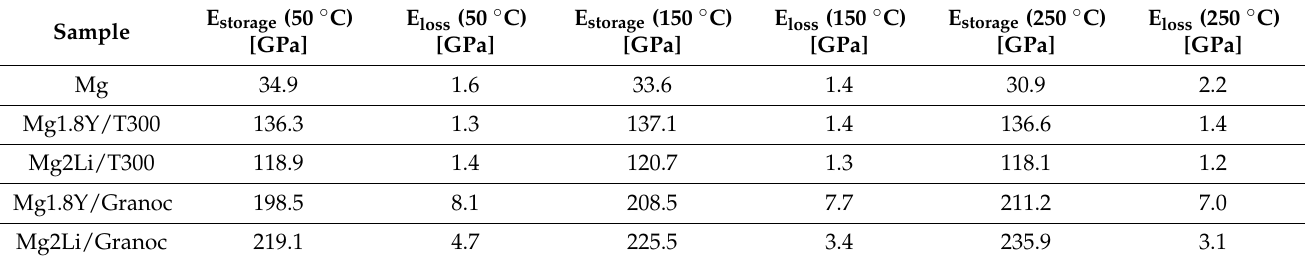
Table 3. Representative values of the storage and loss moduli of Mg-based T300 and Mg-based Granoc